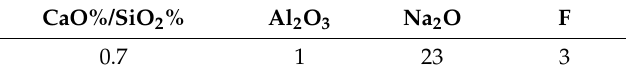
Table 1. Composition of mold flux and mass percentages.